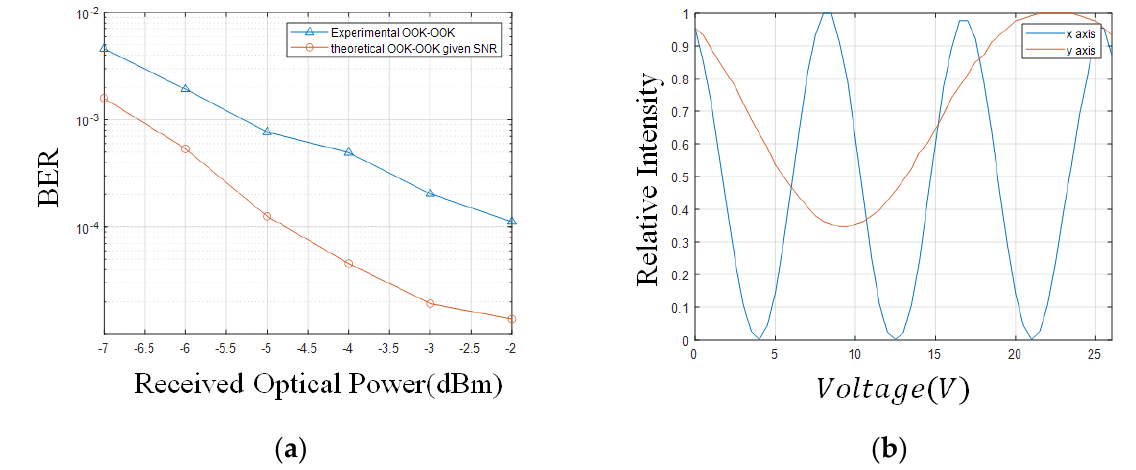
Figure 8. ( a ) Experimentally measured OOK − OOK vs. theoretical OOK − OOK for given SNR relative optical power vs. BER graph. ( b ) Measured normalized intensities of the X − and Y − axes according to voltage change.